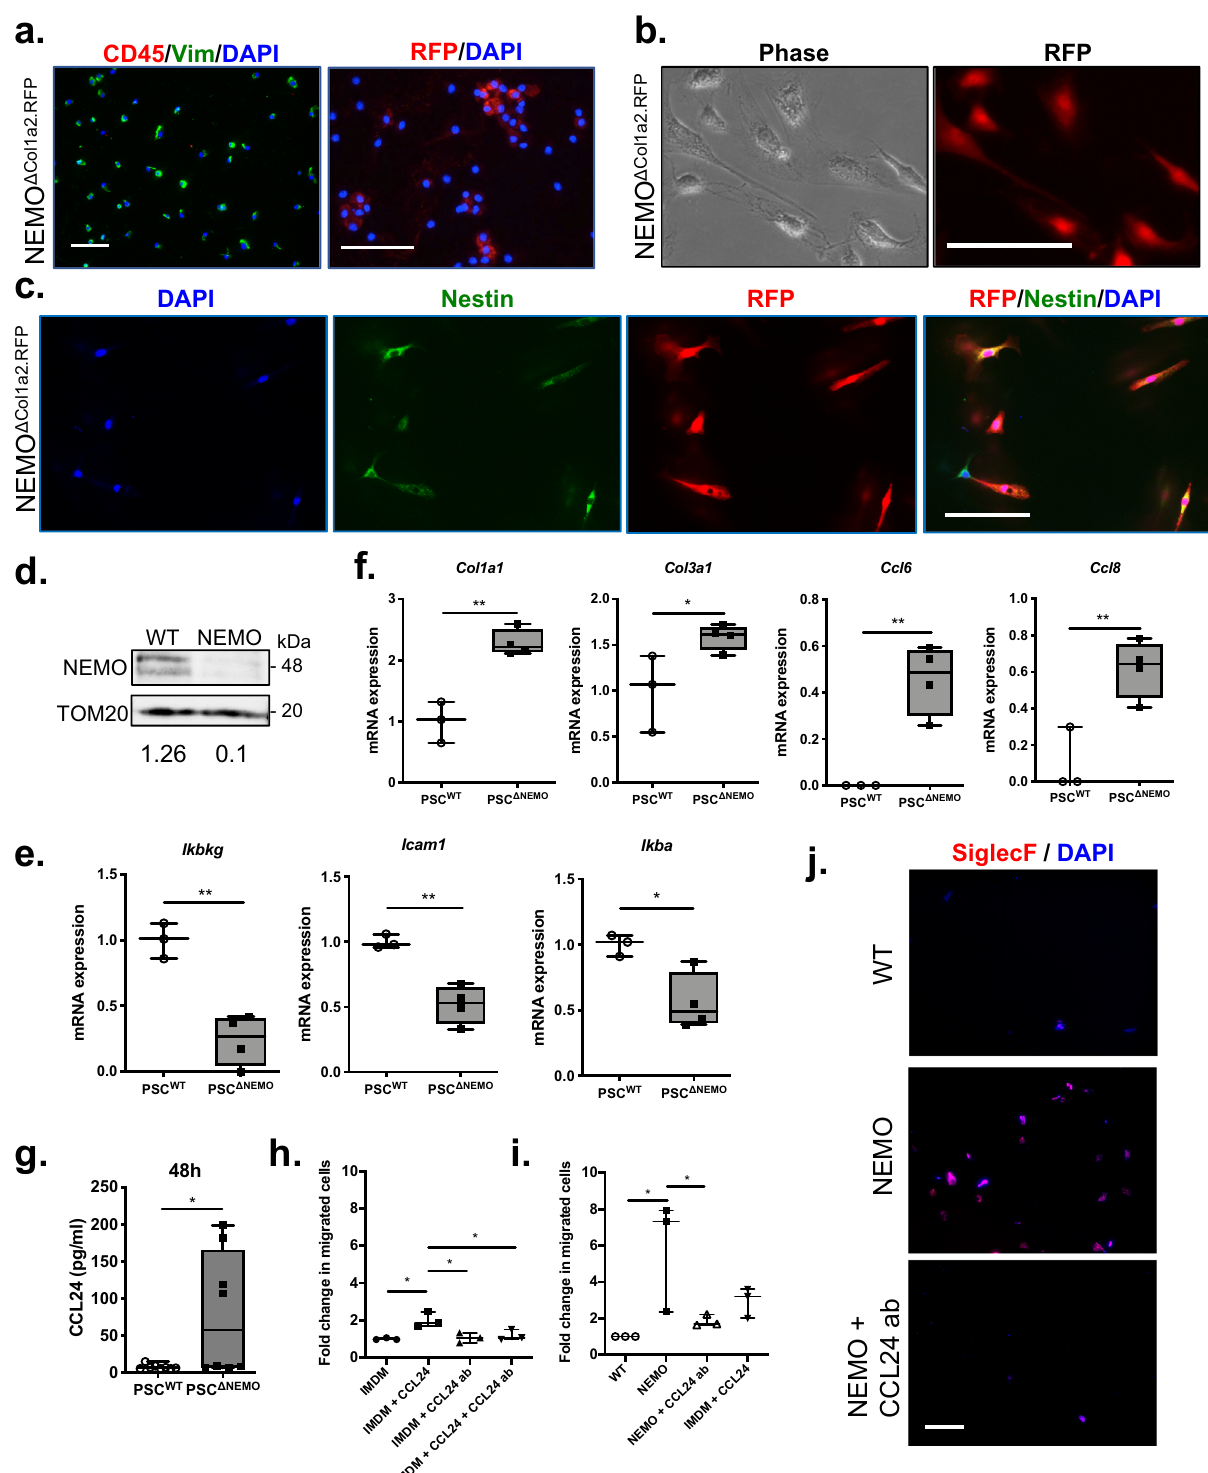
Fig. 8 PSC Δ NEMO cells promote eosinophilia through the secretion of CCL24. a Stainings of Vim, CD45 and RFP on freshly puri fi ed PSCs isolated from NEMO Δ Col1a2.RFP mice (3-week time point). b , c PSCs formed fi broblastoid morphology and express RFP. RFP and nestin stainings on PSCs after 24h in culture. d Immunoblot of NEMO on PSC protein extracts. TOM20: loading control. WT: PSC WT ; NEMO: PSC Δ NEMO . e , f Gene expressions in PSCs analyzed by qPCR (PSC WT : n = 3; PSC Δ NEMO : n = 4). g Measurement of CCL24 level by ELISA from culture media collected at 48 h ( n = 8). Whiskers: Min to Max. T -test (two-tailed): * p < 0.05; ** p < 0.01. h , i Transwell migration assay indicating the fold change of the immune cells towards different media. Media: PSC WT (WT) and PSC Δ NEMO (NEMO) conditioned media (72 h); media with an addition of CCL24 ligand or neutralization with CCL24 antibody (ab). n = 3. One-way ANOVA: * p < 0.05. j Staining of Siglec-F on the transmigrated cells. DAPI: nuclei. Scale bar: 100 µ m. All n numbers represent biological